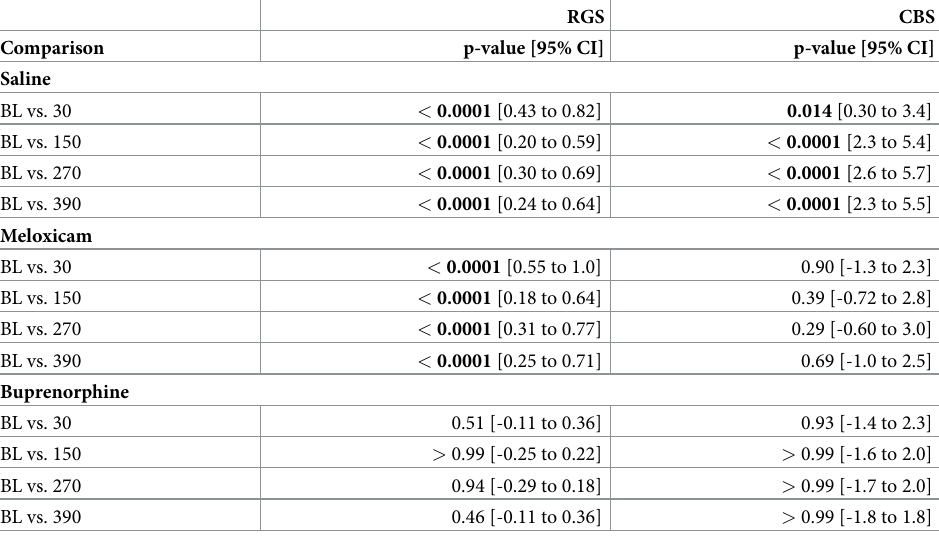
p-values and 95% confidence intervals of the differences are reported for each